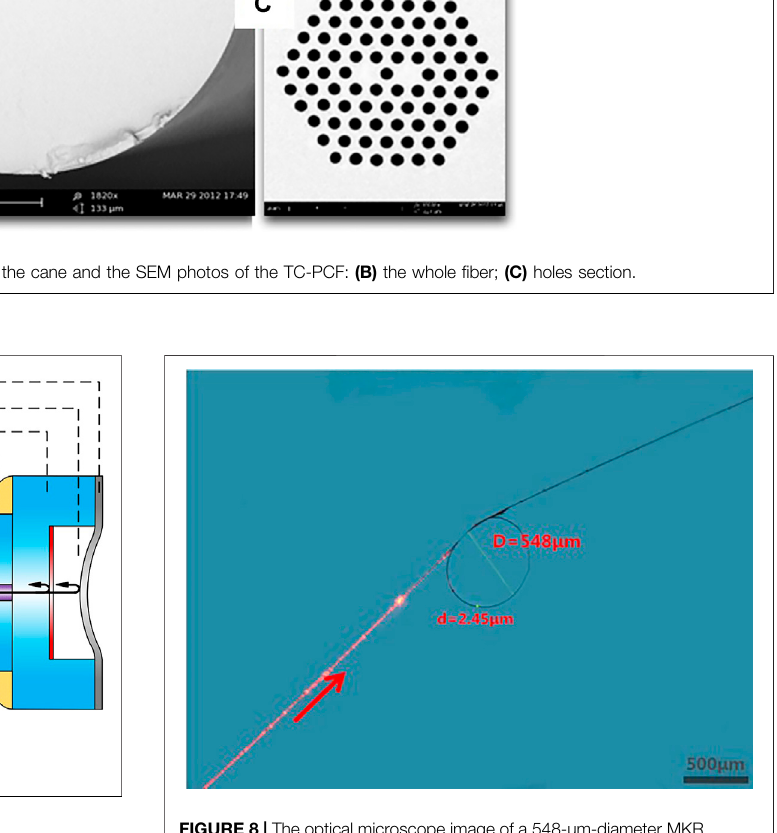
FIGURE 8 | The optical microscope image of a 548- μ m-diameter MKR with a 2.45- μ m-diameter micro fi